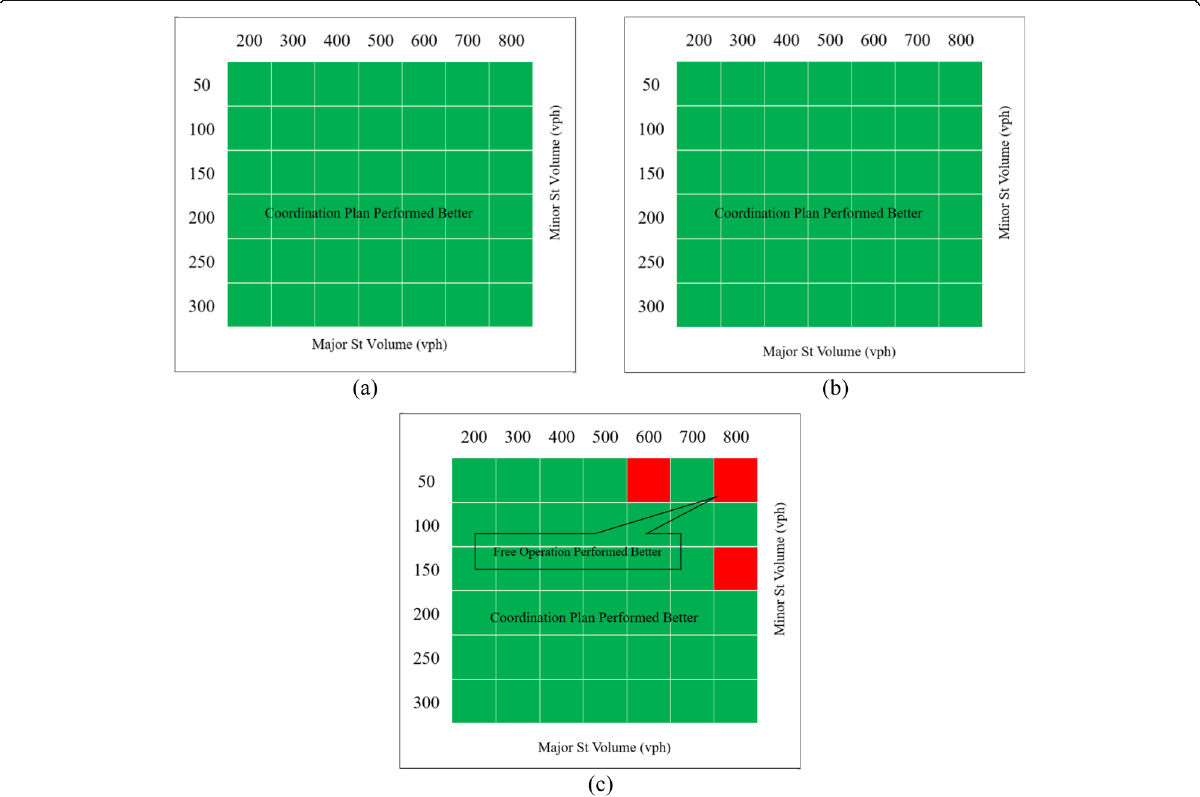
Fig. 9 Performance Comparison between Coordination Plans and Free Operation, a 100-s Coordination Plan; b 150-s Coordination Plan; c 200-s Coordination